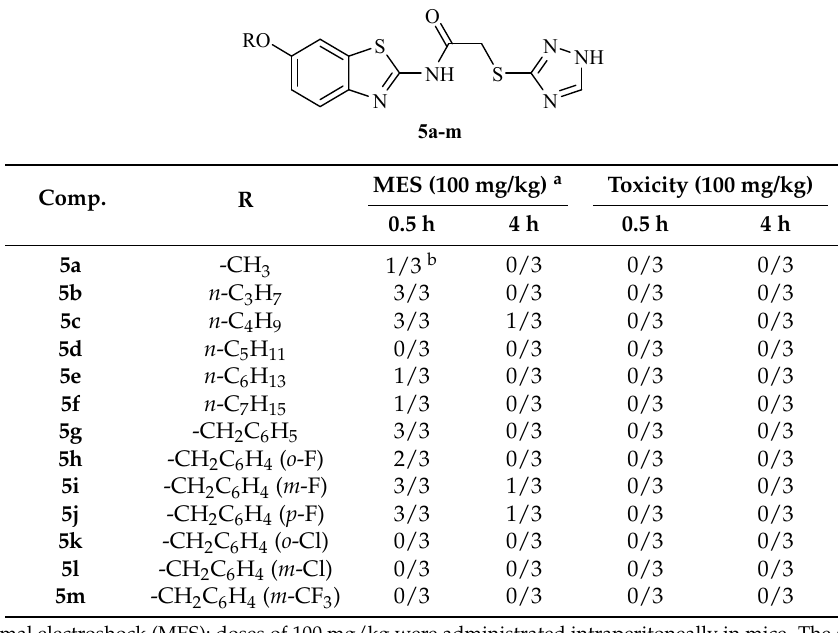
Table 1. Anticonvulsant activities screening (maximal electroshock test) and neurotoxicity screening in mice at the dose of 100 mg/kg.